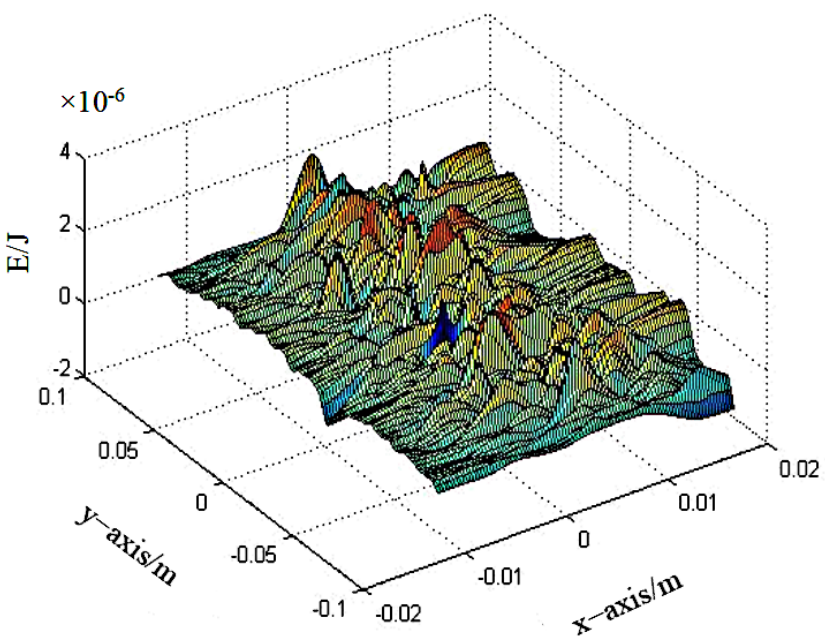
Figure 22. Coating impact kinetic energy E distribution.